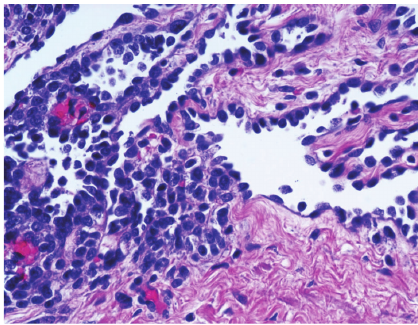
Figure 5: Image of the tumor demonstrating the merging of the solid component composed of Sertoli cells with the Sertoli cells lining the slit-like spaces (H&E, 400x).